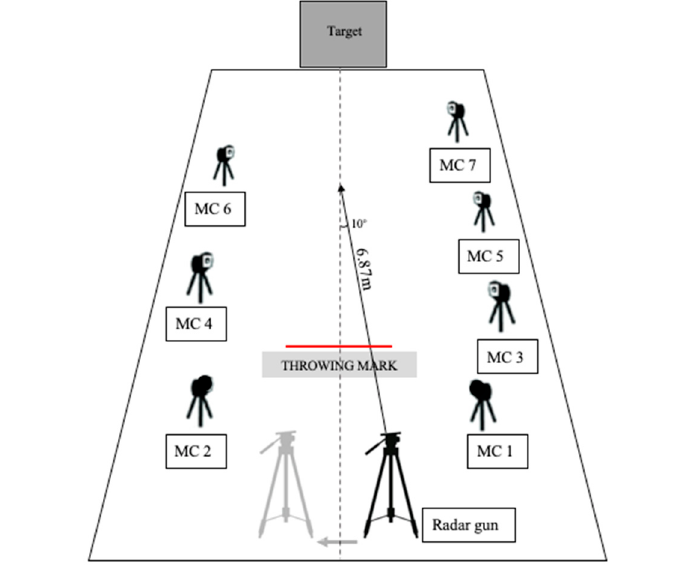
Figure 1. Schematic of the experimental set